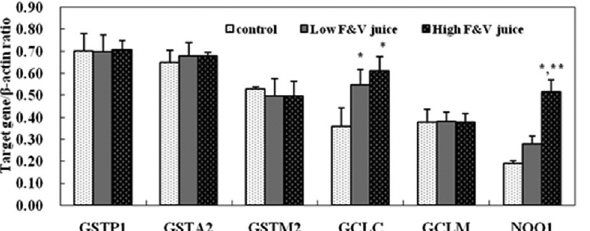
Figure 3 - Expression of antioxidant genes in rat colon (n = 12). Rats re- ceived saline water (control), low fruit and vegetable (FV) juice dosage, andhighFVjuicedosagefor5weeks.Theanimalsweresacrificedandco- lon samples were collected for target gene expression detection by RT- PCR method. (cid:2) -actin was used as endogenous reference gene, and every experiment was repeated for three times. Values represent relative band density (normalized to the endogenous reference gene (cid:2)